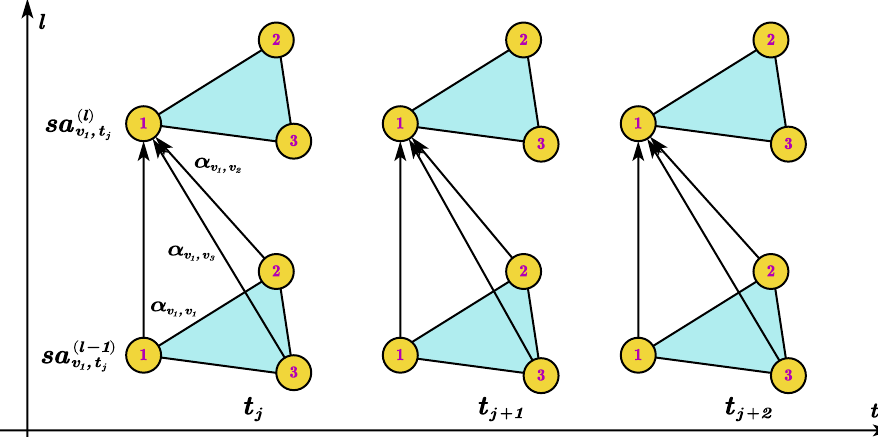
Fig. 3 Principle of spatial